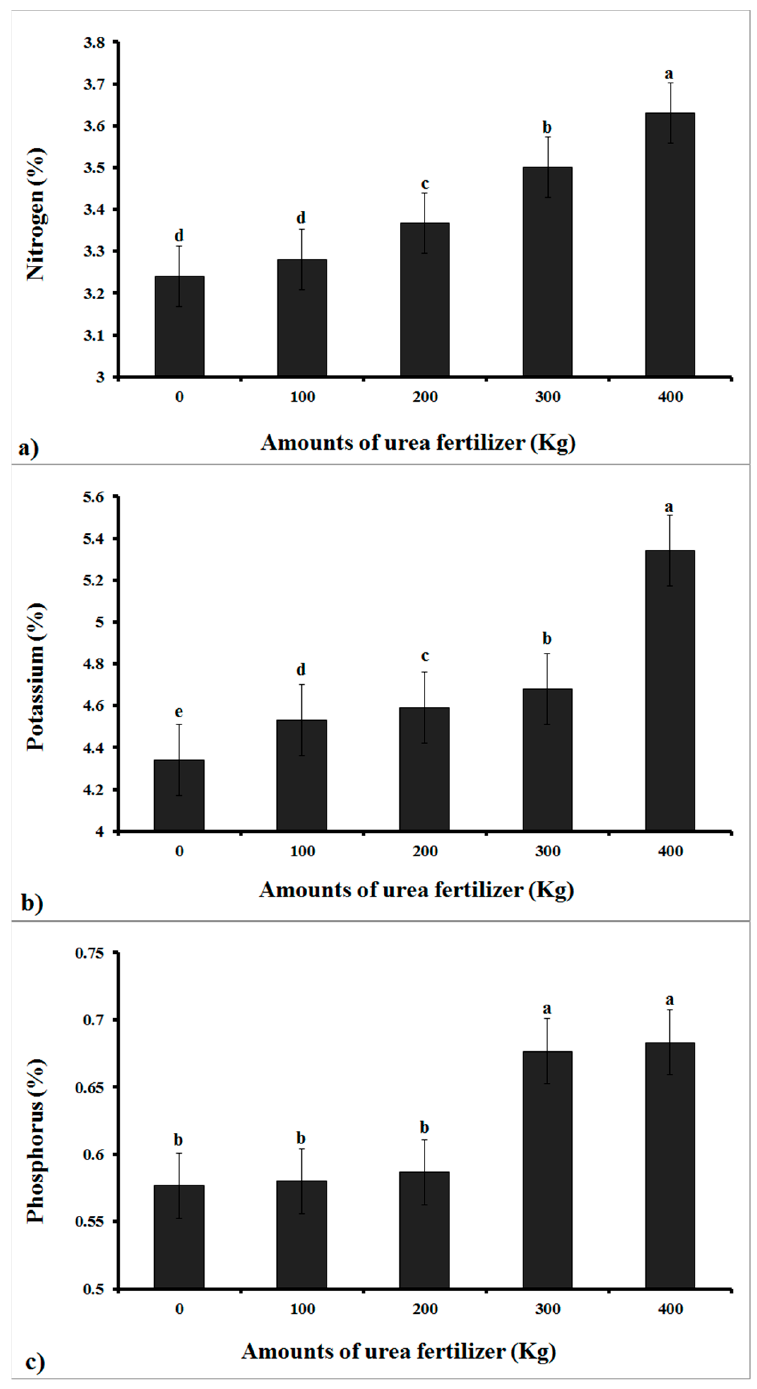
Figure 2. Results of Duncan’s multiple range mean comparison tests for analysis of estimated nutri- ent contents in cucumber fruits for: ( a ) Nitrogen ( b ) Potassium, and ( c ) Phosphorus. Values with the same letter (a–e) are not significantly different at P = 0.01.